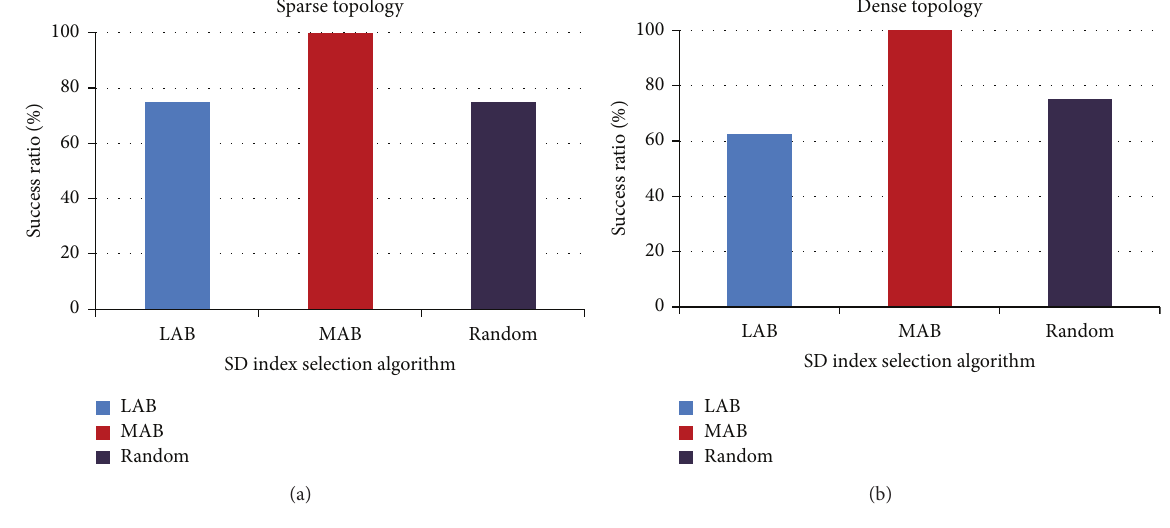
Figure 13: Experiment results of E-DSME beacon scheduling.